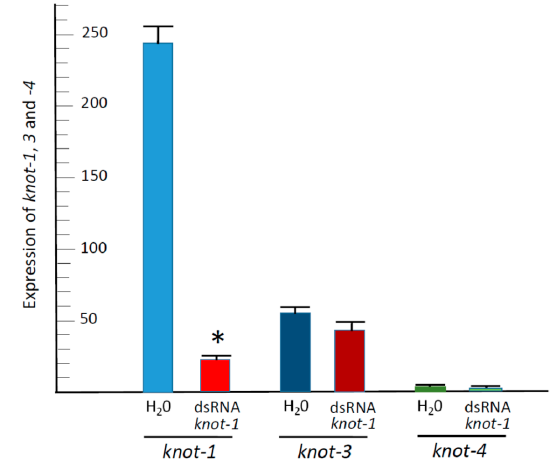
Figure 4. Expression of knot ‐ 1; ‐ 3; and ‐ 4 upon knot ‐ 1 silencing. qPCR quantification of knot transcripts (relative to β ‐ actin transcripts) from whiteflies caged for 48 h with tomato leaflets bathing in water (H 2 O) or in knot ‐ 1; ‐ 3 and ‐ 4 dsRNA (dsRNA); ( n = 3; mean ± SEM). An asterisk above the bars indicates significant differences between treatments at p < 0.05.